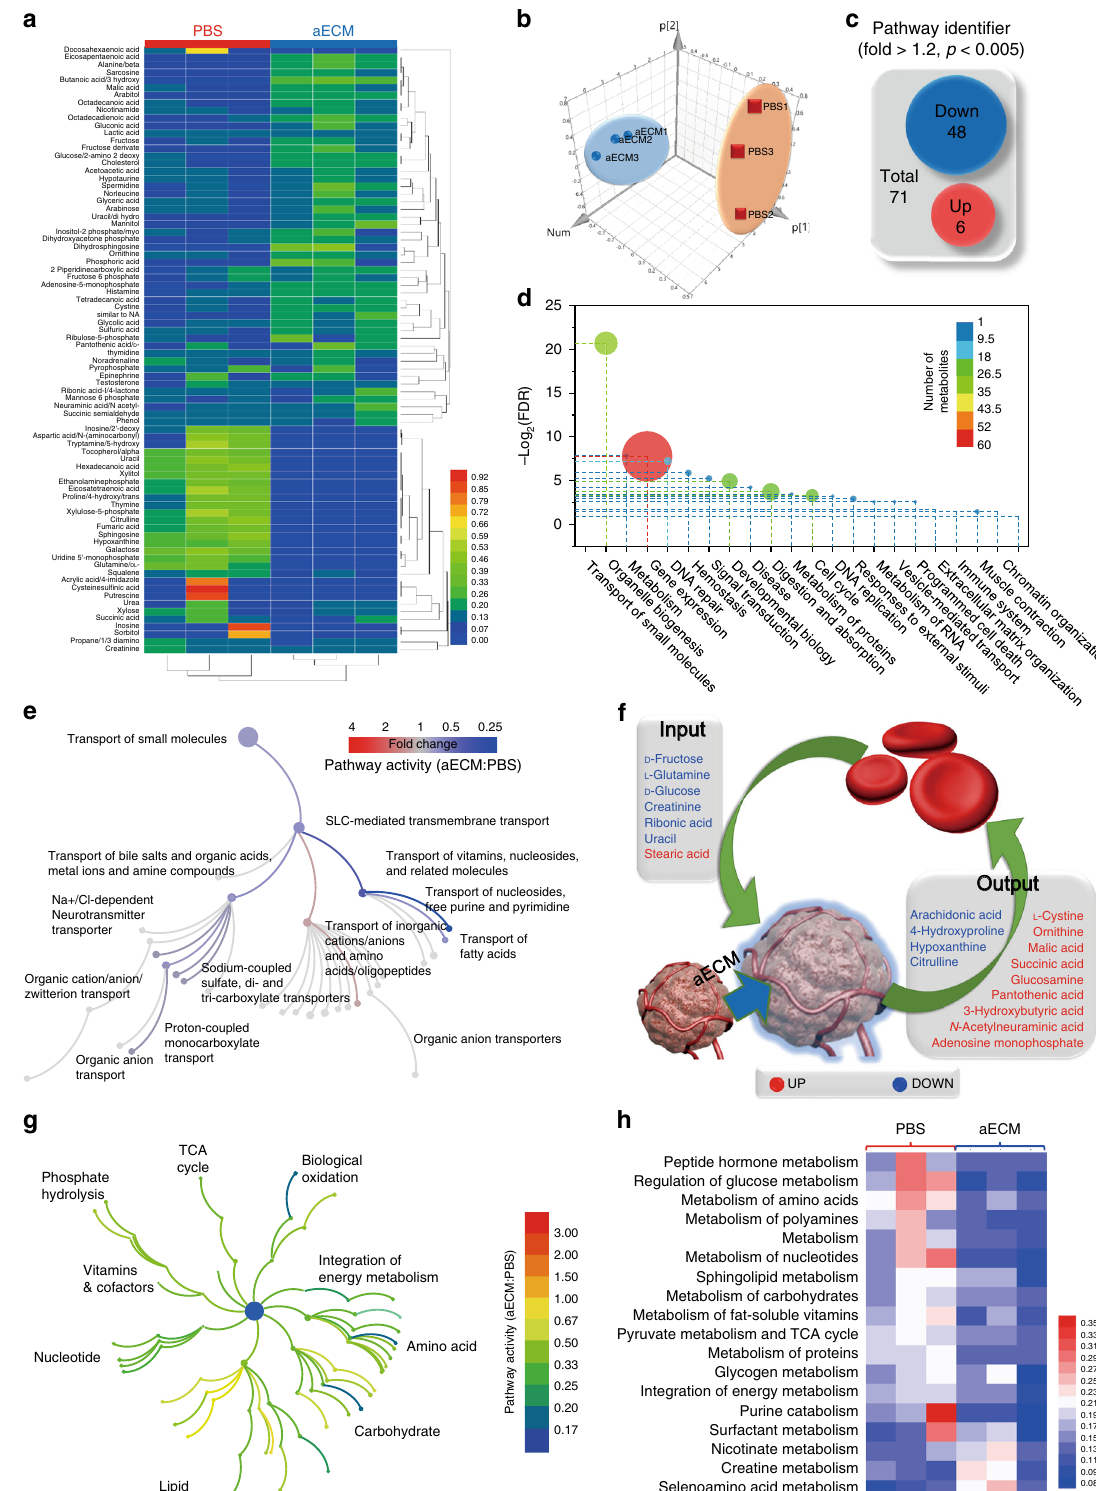
(Fig. 5c). This result indicated that the insoluble fi brin formed in situ dramatically diminished the permeability of small molecules through the tumor